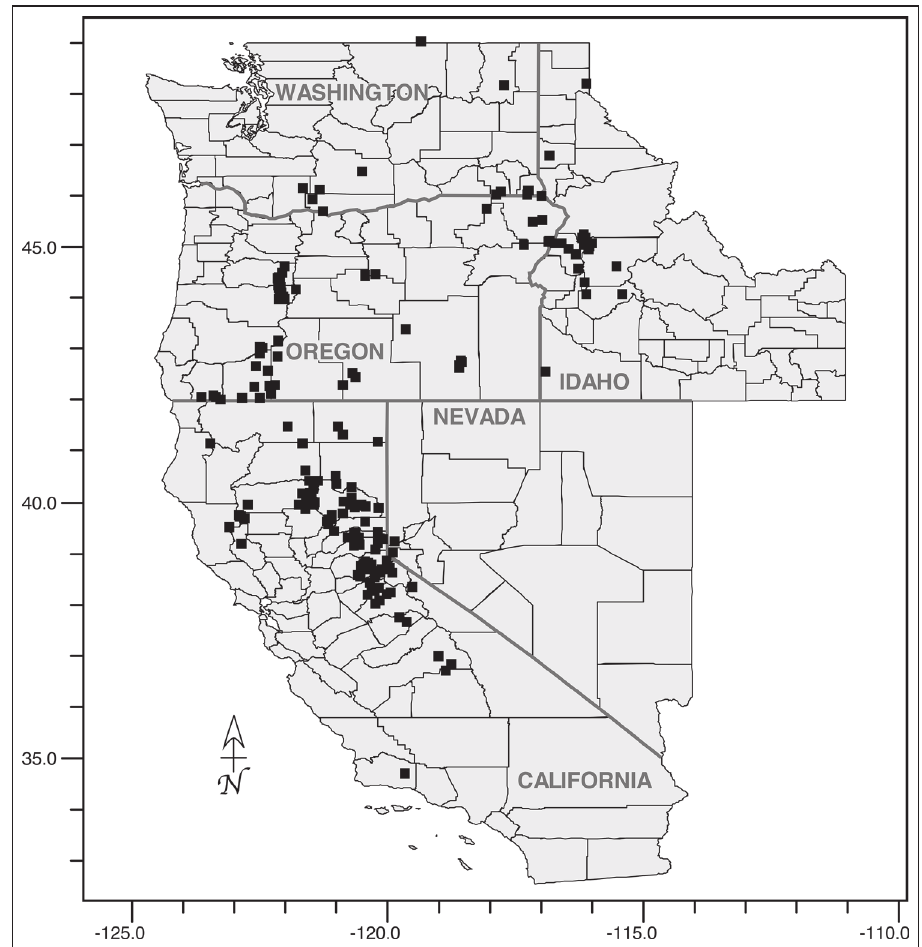
Figure 2. Distribution of Navarretia divaricata (black squares) occurrences across its native range in the western United